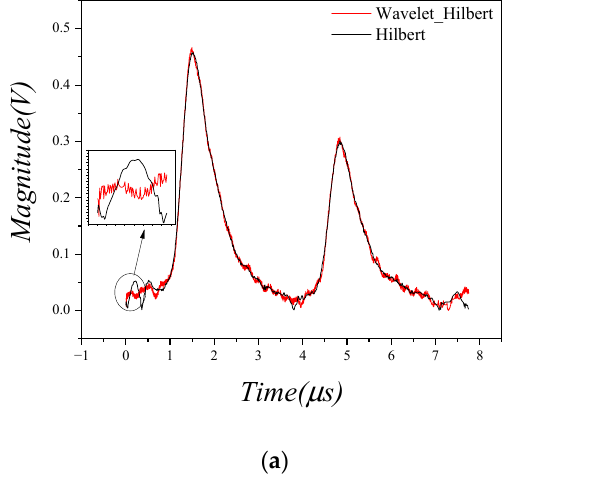
Figure 13. Comparison of signals ( a ) before and after wavelet filtering, and ( b ) before and after interpolation.